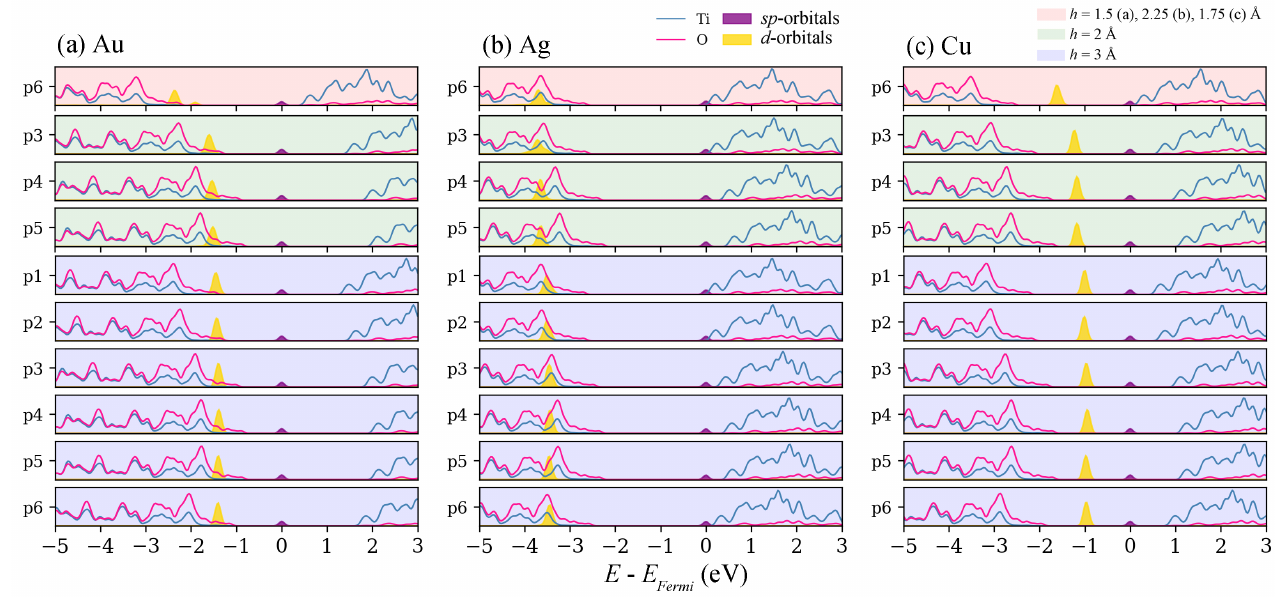
Figure 2. Density of states (DOS) of deposited Me s on the TiO 2 surface for Au ( a ), Ag ( b ), and Cu ( c ) surface structures. The zero at energy scale is set to the Fermi level for each surface structure. Considering TiO 2 , DOSes are projected to the Ti (blue line) and O (pink line), respectively. The sp -orbitals (purple area) and d -orbitals (yellow area) of Me s are elucidated. The background color for each panel are as follows: suspended Me s ( h = 3 Å; light blue space), between suspended and bonded Me s ( h = 2 Å; light green space), and bonded Me s ( h = 1.5 Å for Au, 2.25 Å for Ag, and 1.75 Å for Cu; light red space),